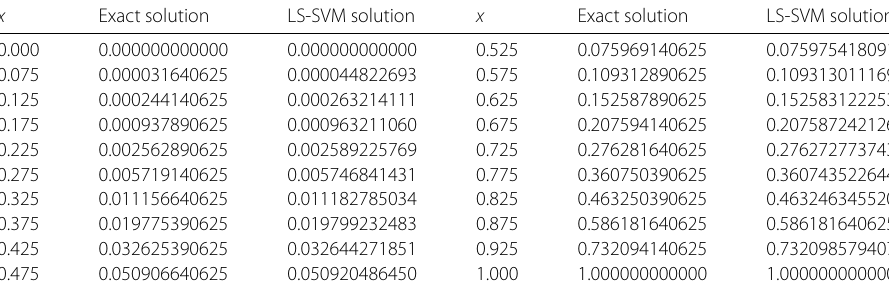
Table 5 Comparison between exact solution and LS-SVM solution (Example 5) x Exact solution LS-SVM